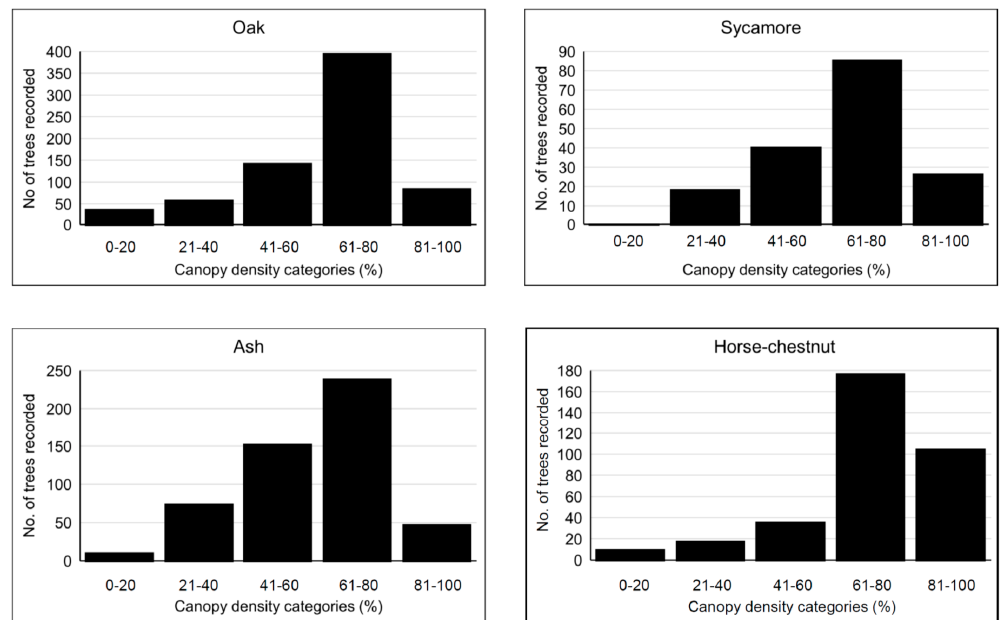
Figure 3. Frequency of occurrence of canopy density in five classes for the four most commonly recorded tree species in England only.